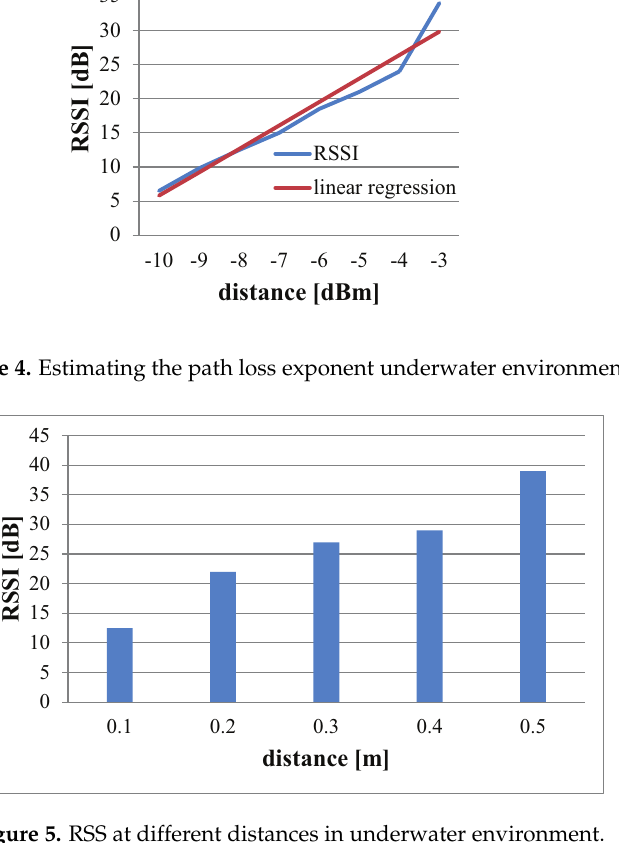
Figure 5. RSS at different distances in underwater